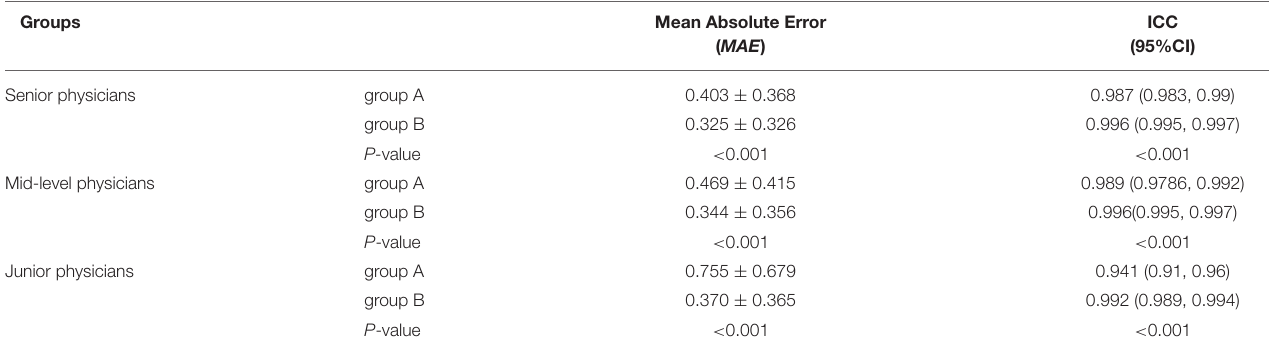
TABLE 2 | Assessment performance for physicians with different levels of experience with no additional information (group A) and with artificial intelligence model assistance (group B). Groups